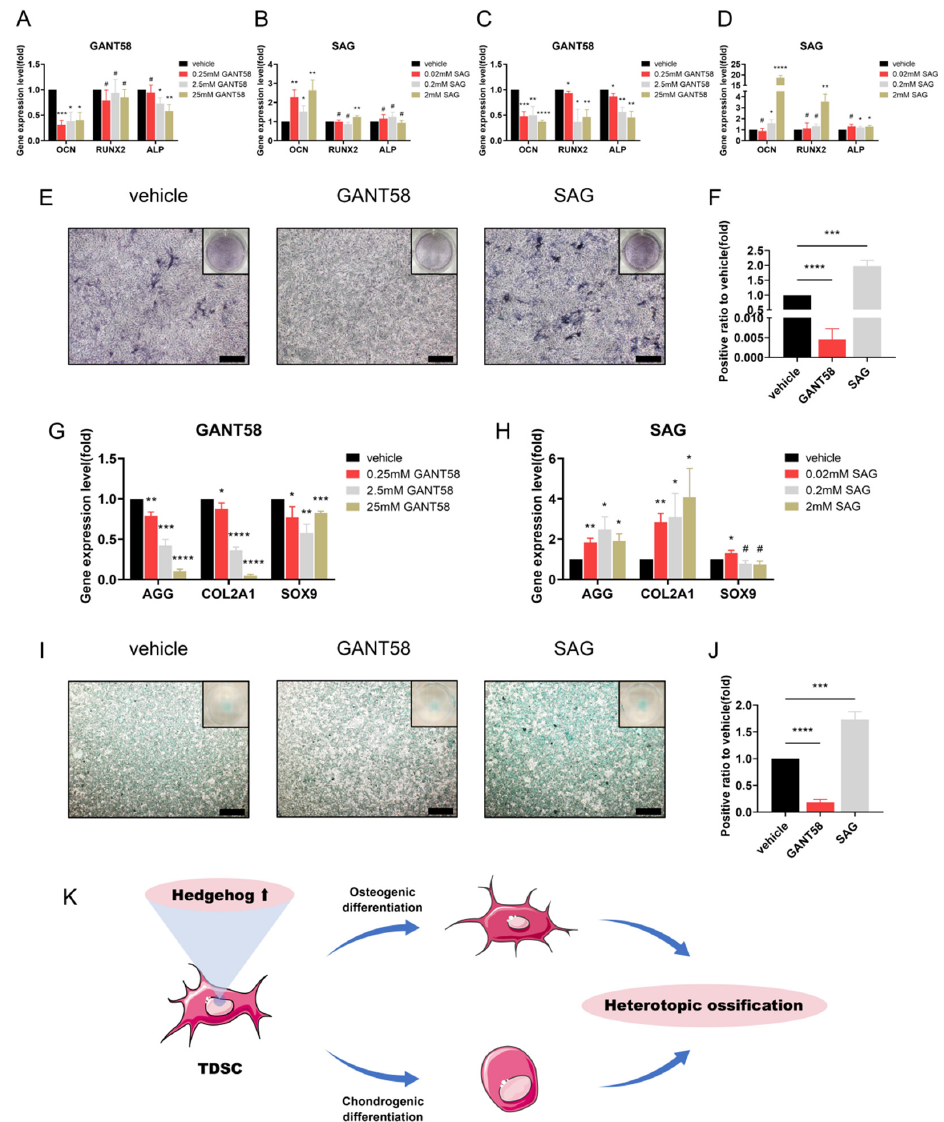
Figure 5. Hedgehog signalling regulates osteogenic and chondrogenic differentiation in tendon ‐ de ‐ rived stem cells (TDSCs). ( A ) qRT–PCR analysis of OCN, RUNX2, and alkaline phosphatase